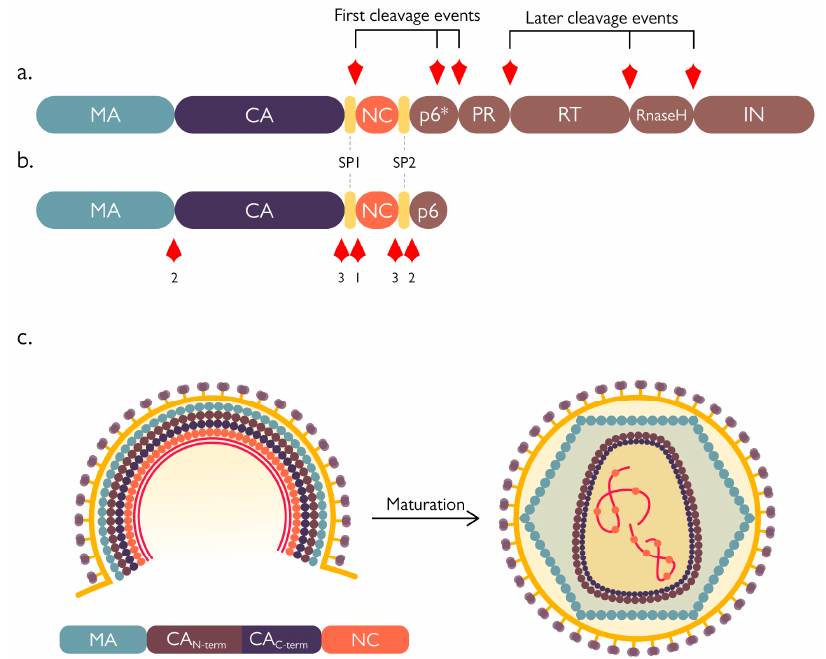
Figure 4. Processing of HIV-1 polyproteins by the viral protease. ( a ) Ordered processing of Gag-Pol by the poorly-active protease (PR) precursor still embedded in the polyprotein context. The first cleavage events aim at separating PR from the polyprotein at its N-terminus (separating the PR from the transframe domain p6*), later events finally free the protease from the rest of the precursor. ( b ) Processing of Gag by the mature PR. Maturation occurs in a precise and ordered manner (events order is numbered 1–3), with the first cleavage occurring between the nucleocapsid (NC) and spacer peptide (Sp)1, then between the matrix (MA)/capsid (CA) and SP2/p6, and lastly, the CA and NC are separated from the spacer peptides. ( c ) Schematic representation of virion maturation.